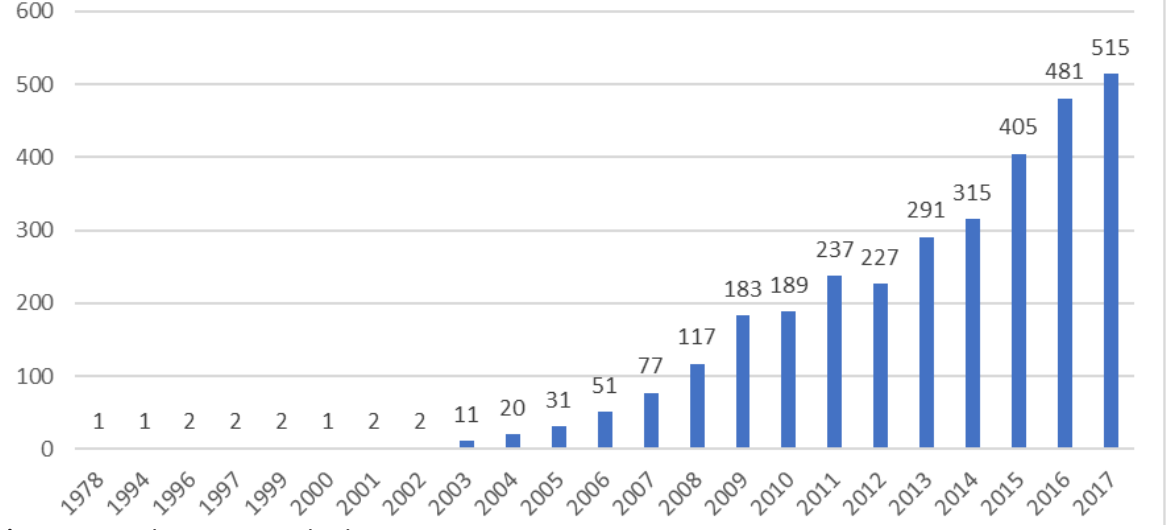
Figure 4. Evolution of CSR